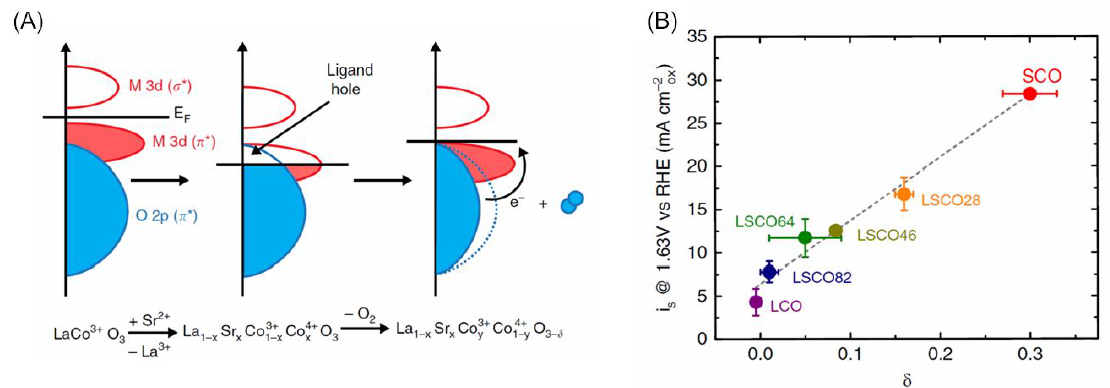
Figure 4. ( A ) Scheme showing the presence of oxygen vacancies with the introduction of Sr in LaCoO 3 (adapted from [26]). ( B ) Specific OER activity of La 1 − x Sr x CoO 3 − δ and IrO 2 at 1.63 V (vs. RHE) (adapted from